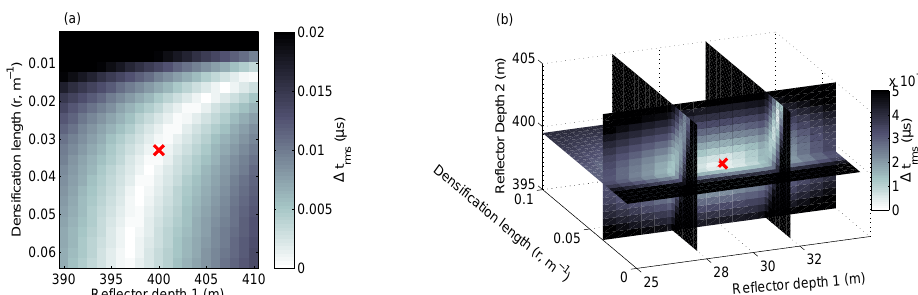
Figure 4. Traveltime residuals ( (cid:49)t rms ) calculated with ray tracing between ideal reflector in a fixed depth–density profile ( A = 460kgm − 3 ; r = 0.033m − 1 ) with reflectors perturbed in terms of depths and density. Ideal solutions are marked with red crosses: (a) traveltime residuals for an ideal reflector at 400 m depth; (b) volumetric slice plot of traveltime residuals for two idealized reflectors at 30 and 400m depth.